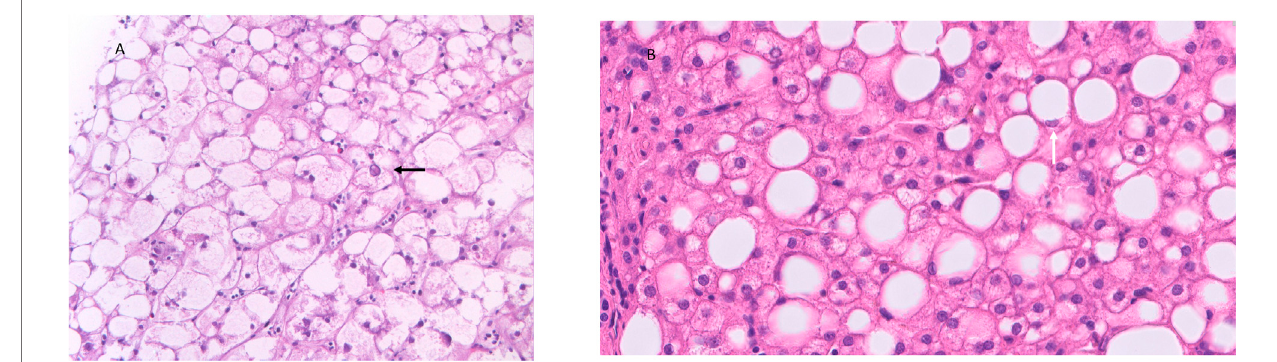
FIGURE 1 | Histology features of GlyH and liver steatosis. Caption: (A) The liver parenchyma in GlyH is composed of enlarged, swollen hepatocytes with a pale cytoplasm due to the accumulation of glycogen. In the center a hepatocyte with a glycogenated nucleus can be observed (black arrow) (HE, 40x). (B) The liver parenchymashows severalsteatotic hepatocytes,correspondingtomacrovesicularsteatosis(HE, 20x).Asteatotic hepatocyte hasacompressed nucleus, surrounded by an “ empty ” cytoplasm. The empty appearance of the cytoplasm is due to the dissolution of the fatty acids in the cytoplasm during the technical process (white arrow) (HE, 40x).